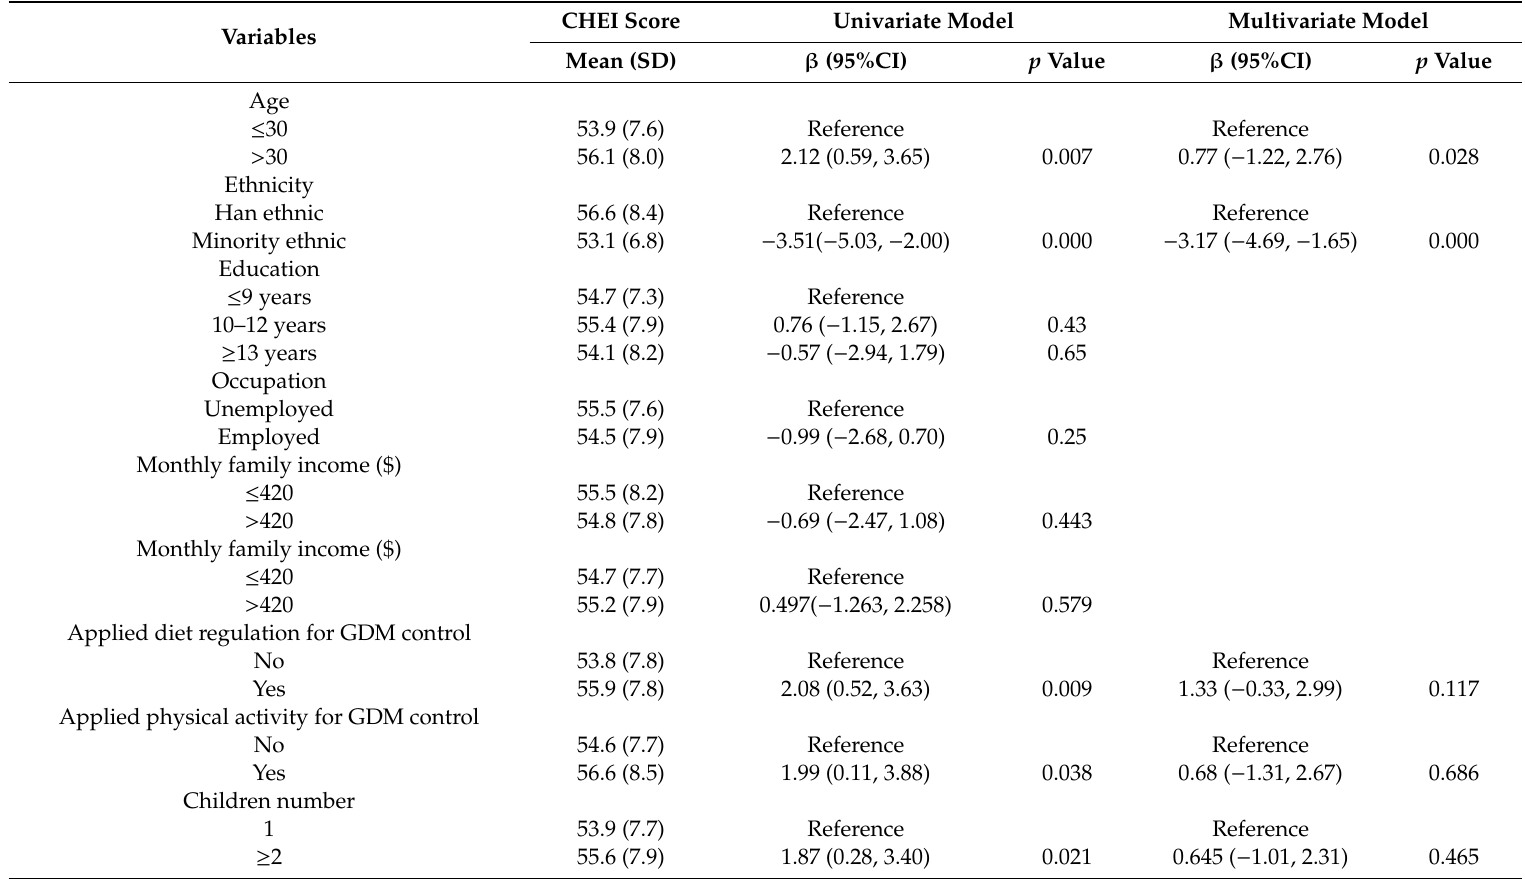
Table A2. Linear regression analysis of the association between total CHEI score and socio-demographic, anthropometrics factors.